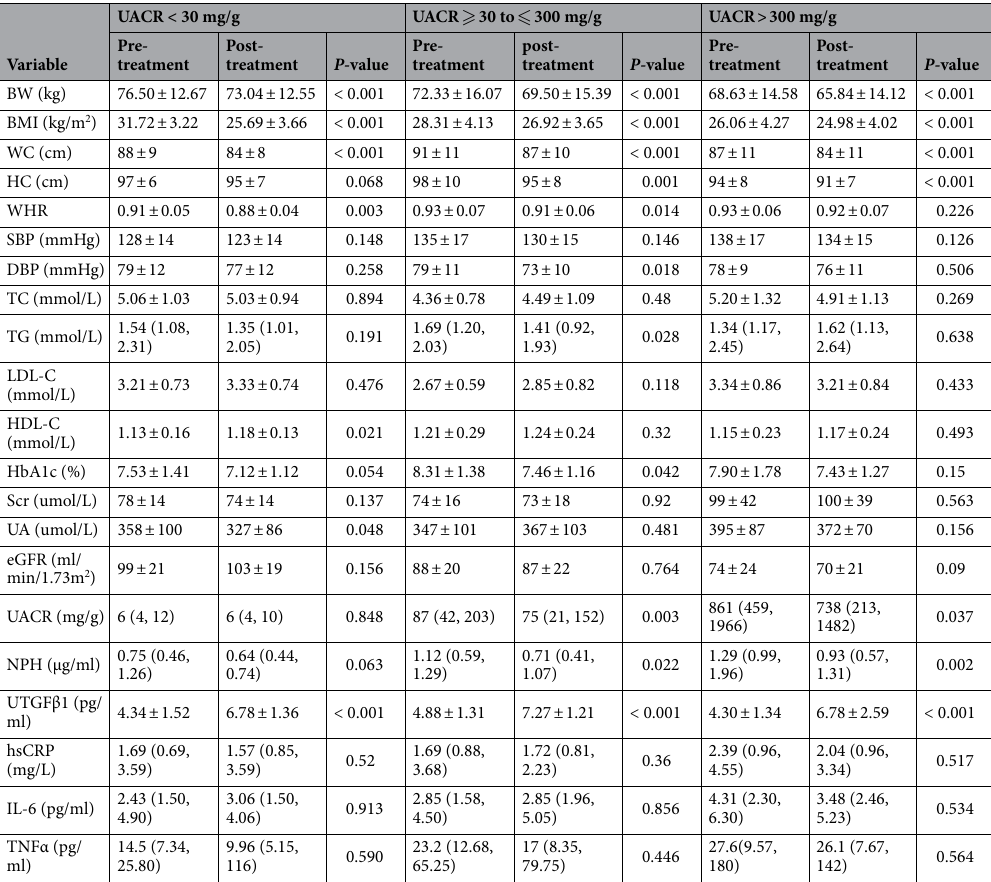
Table 2. Comparisons of parameters before and after 12- week treatment with SGLT2 inhibitors in type 2 diabetes. Data are expressed as mean ± standard deviation or median (interquartile rang). BW body